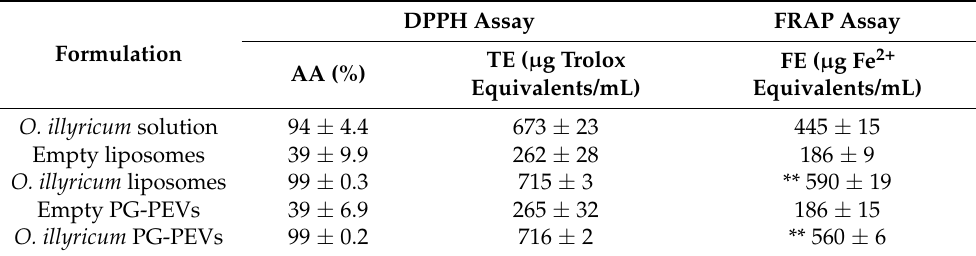
Table 6. In vitro antioxidant activity of O. illyricum formulations. For the DPPH assay, results are expressed as AA (antioxidant activity %) and TE ( µ g Trolox equivalents/mL solution); for the FRAP assay, results are expressed as FE ( µ g Fe 2+ equivalents/mL